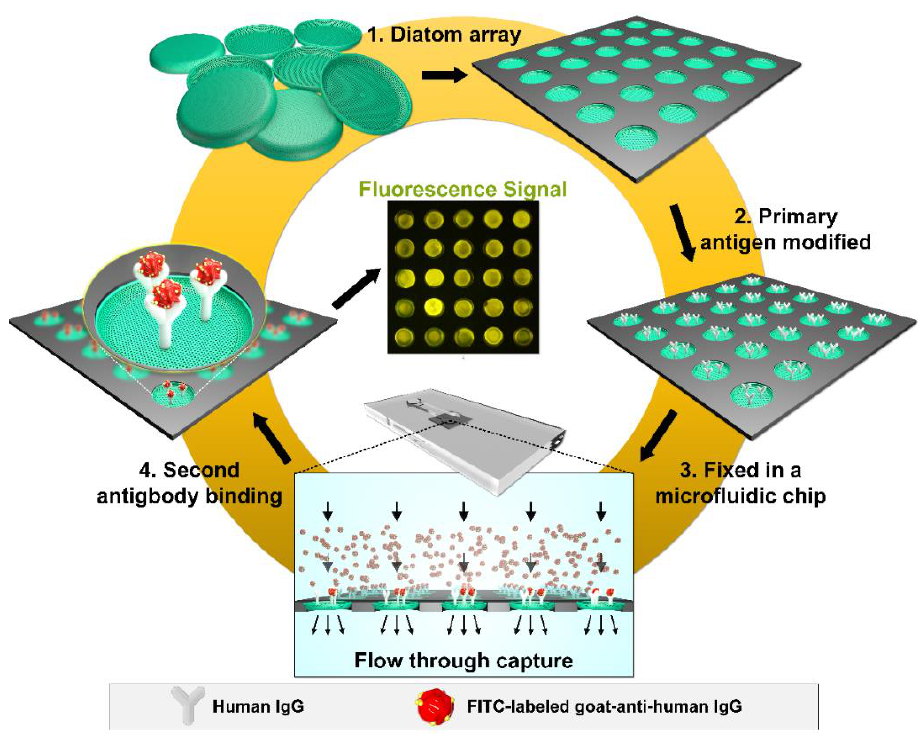
Figure 2. Schematic illustrations of the frustule array modification and detection.